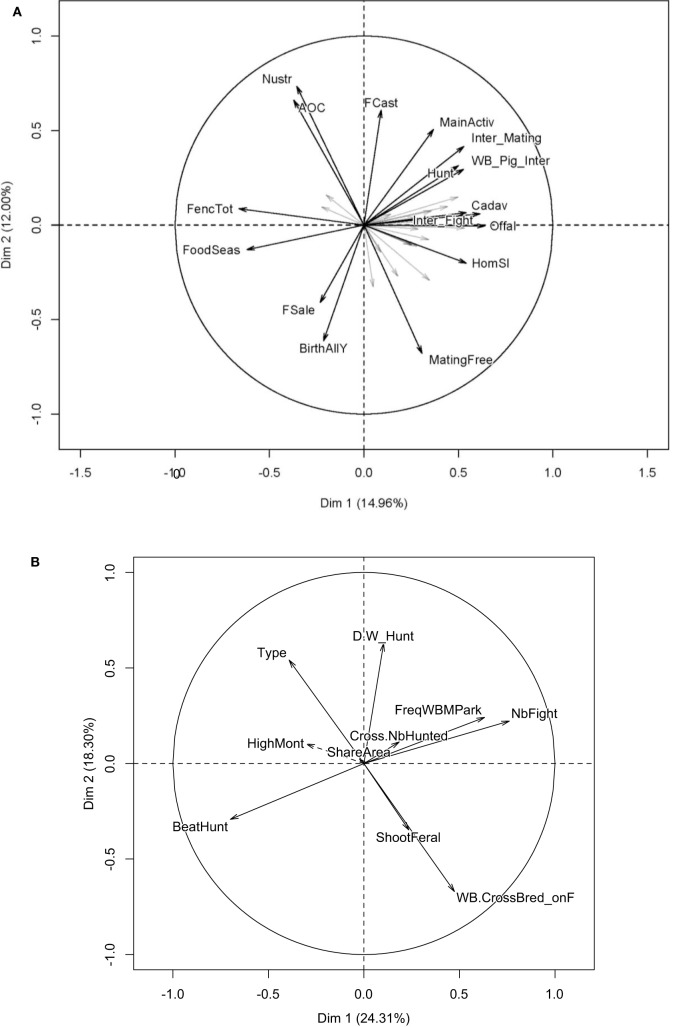
Potential associations between the different practices according to the multivariate exploratory data analysis: (A) correlation circle of the MFA for farming practices (including SF ad HF) and (B) correlation circle of the PCA for hunters (including SH and HF). Legend for the variables in (A) AOC: farmers involved in quality recognition process; BirthAllY: no reproductive synchronization; FCast: sterilization of females; FencTot: total fencing of farm perimeter; FoodSeas: additional food supply; FSale: sale of females; HomSl: slaughtering of pig on the farm; Hunt: farmers practicing hunting activity; Cadav: disposal of the carcasses outdoor (no specific area); Inter_Fight: observation of fighting interaction (Y/N); Inter_Mating: observation of mating interaction (Y/N); MainActiv: farmers having pig farming as main activity; MatingFree: mating of sow in non-fenced area; Nustr: farmers having only Nustrale breed in the farm; Offal: disposal of carcass left-over outdoor (no specific area); WB_Pig_Inter: observation of any IDWS (Y/N). Legend for the variables in (B) BeatHunt: practice driven hunt (Y/N); rossNbHunted: ratio of cross-bred/wild boar by hunt; D.W_Hunt: number of hunting days per week; FreqWBMPark: annual frequency of observed sexual interactions. HighMont: farming in mountainous areas; NbFight: annual number of fights between wild and domestic boars; ShareArea: share of pastures with other pig farmers; ShootFeral: hunter shooting feral pigs (Y/N); Type: pure hunter (no farming); WB.CrossBred_onF: observed presence of wild pigs around the farm. SF, strict farmers; HF, hunting farmers; SH, strict hunters; MFA, multiple factorial analysis.